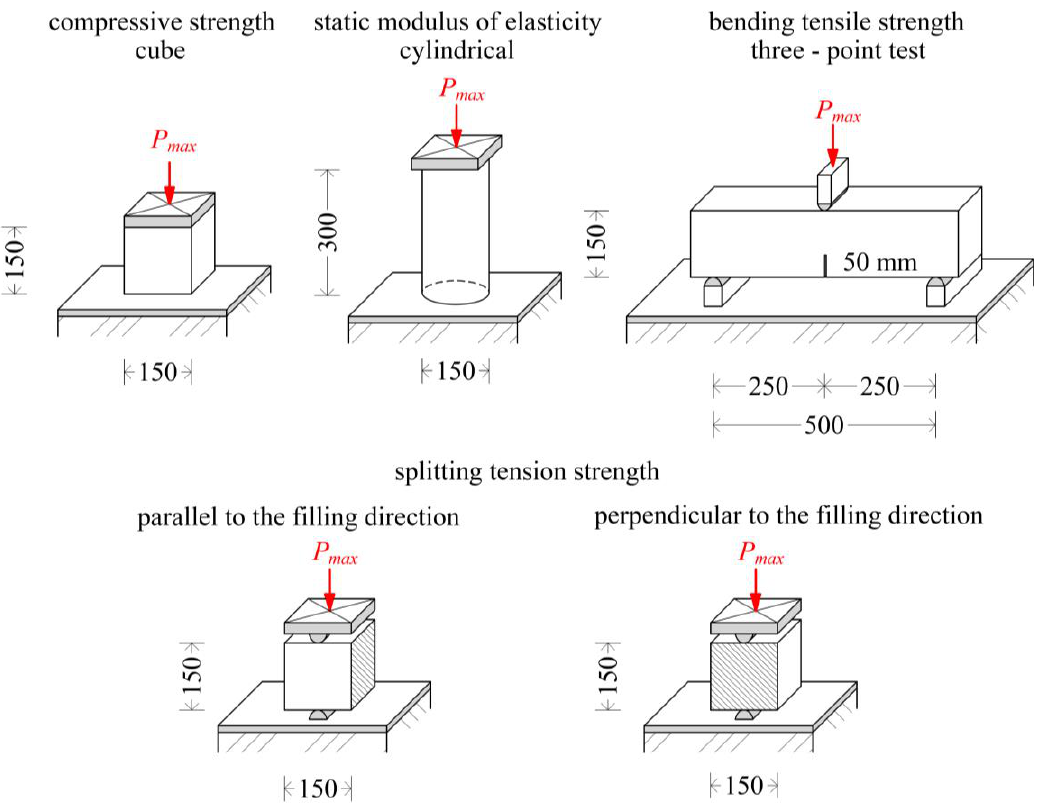
Figure 5. Test scheme in the experimental program according to [34], [39–42].